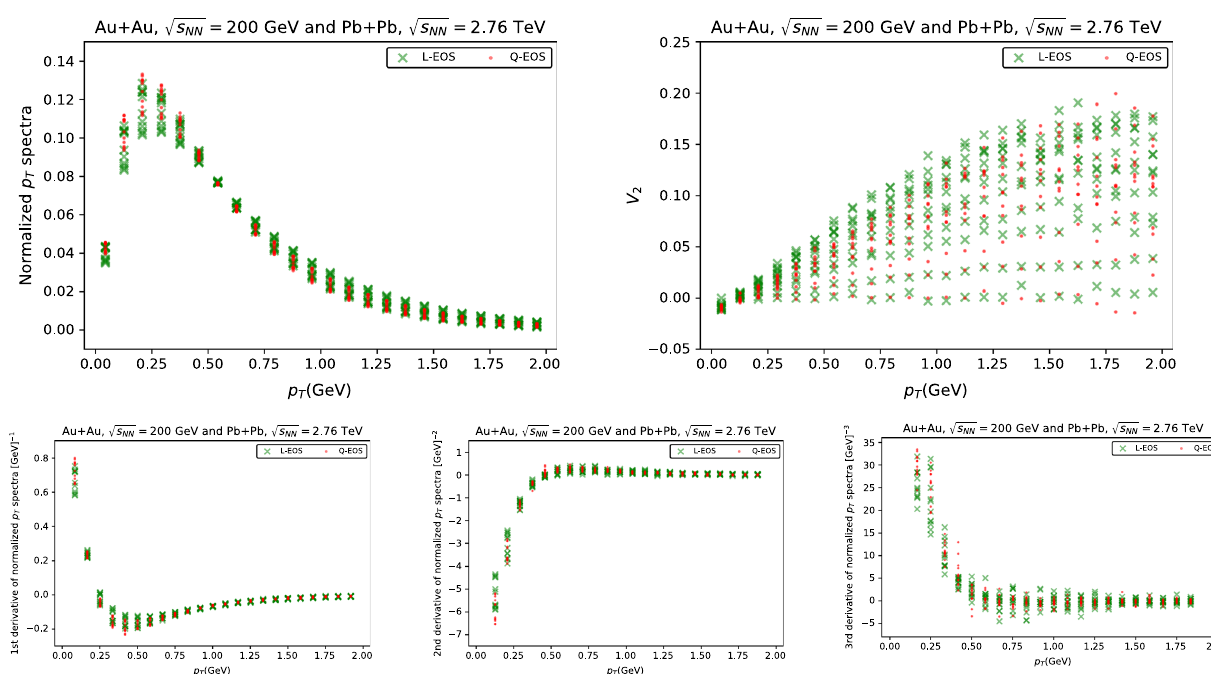
Fig. 11 All-events-fine-averaged normalized p T spectra d N / N d y d p T (upper left panel) and elliptic flow v 2 as a function of p T (upper right panel) and the first, second and third derivative of these normalized p T spectra (lower panel) of the training datasets